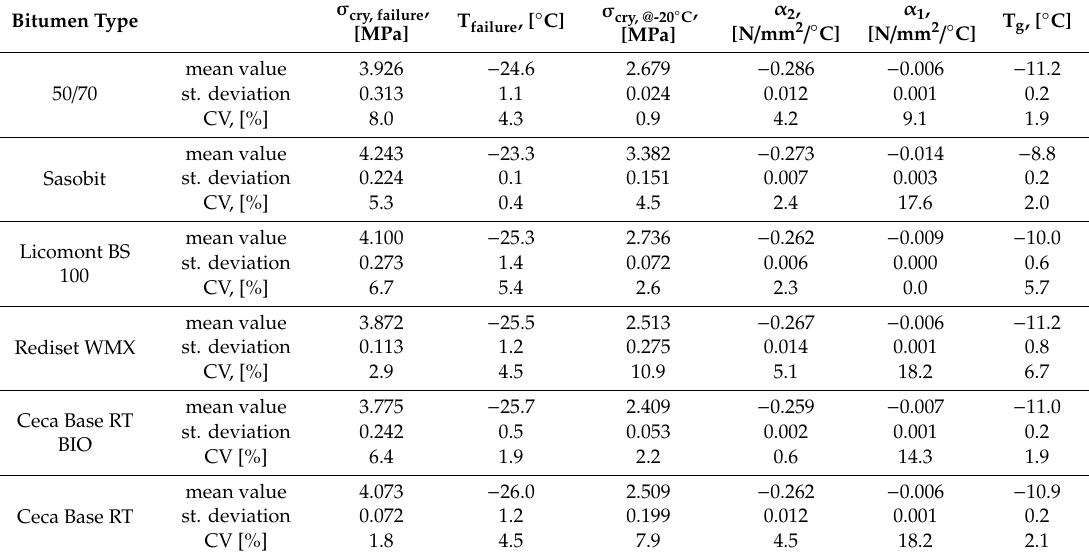
Figure 9. Results of thermal (cryogenic) stresses recorded during TSRST. Table 4. Results of the TSRST test.